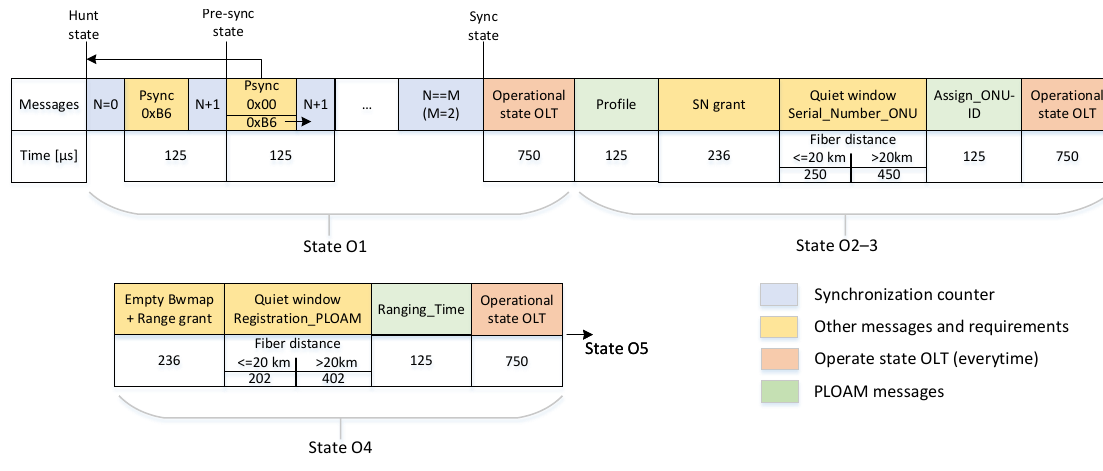
Figure 5. Visualization of the XGPON